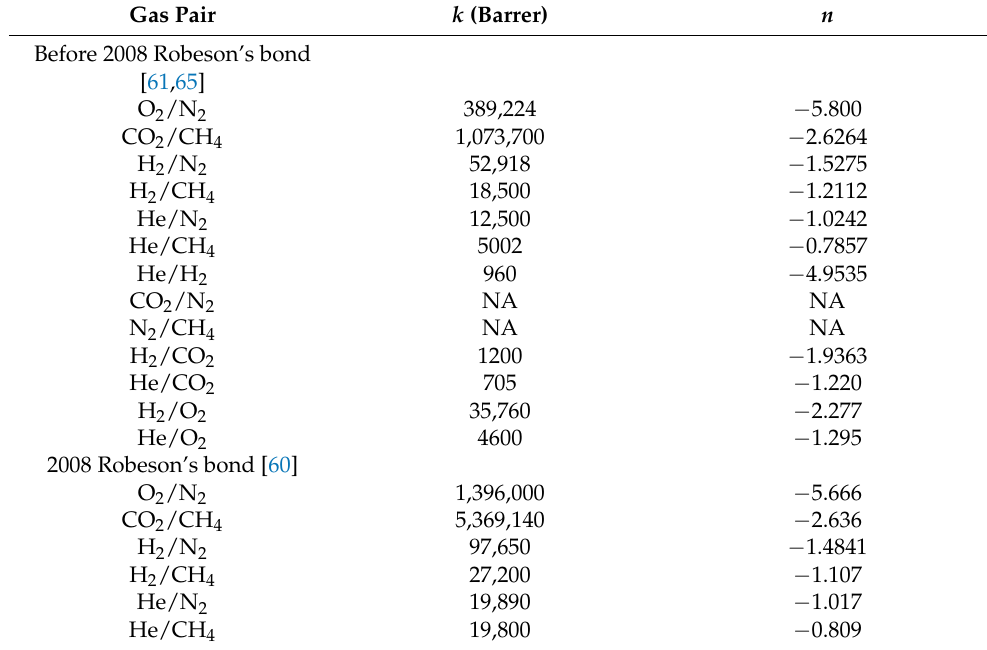
Figure 5. CO 2 /CH 4 Robeson plot for conventional glassy polymers. CA: cellulose acetate; PPO: poly(phenylene oxide); PTMST: Poly(trimethylsilylpropyne); TB-Bis A-PC: tetrabromobisphenol A poly(carbonate), Matrimid ® : commercial poliimide. Permeabilities for single gases were measured in the range 25–35 °C and pressures from 1 to 20 bar. The continuous line stands for the 2008 upper bound, while dashed line represents the 1991 upper bound (adapted from Galizia and co-workers, 2017). Table 1. Tabulation of the values of upper bound slope n and the front factor k . Table adapted from Robeson,